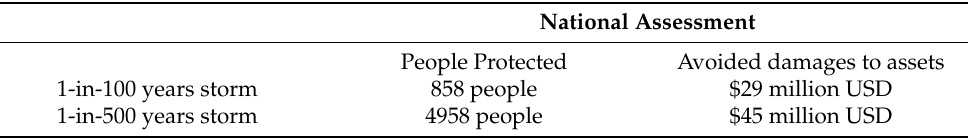
Table 5. Modeled avoided damages in Old Harbour Bay, Jamaica, attributable to mangroves under 2 storm scenarios using different socioeconomic